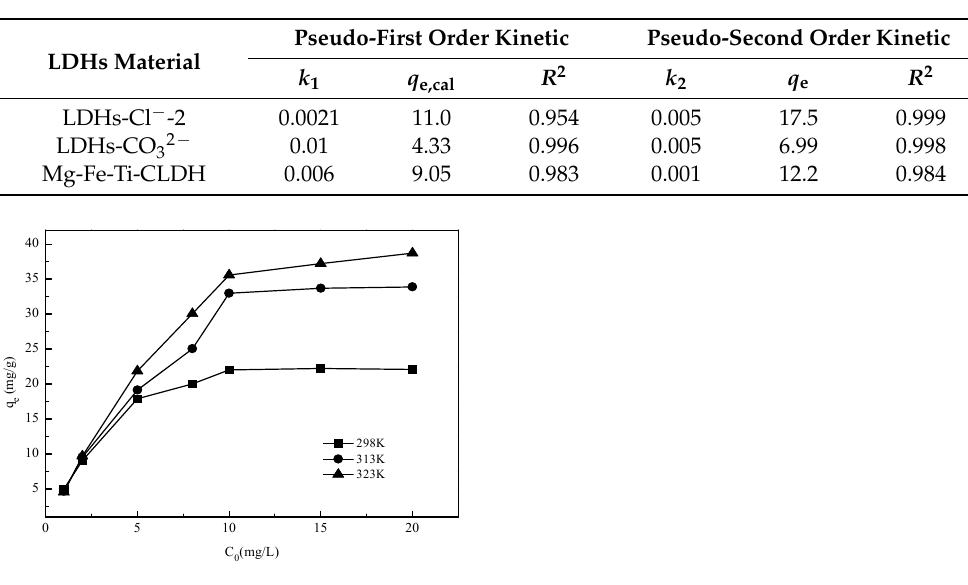
Figure 9. Effect of temperature on vanadate adsorption onto Mg-Fe-Ti-CLDH (experimental condi- tions: C 0 = 1–20 mg/L, adsorbent dosage = 10 mg, pH = 5.0, contact time = 24 h, T = 298–323 K).